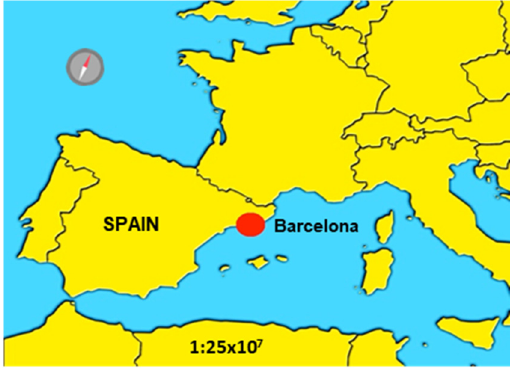
Figure 4. Barcelona’s location, latitude 41.3887901 and longitude 2.1589899.